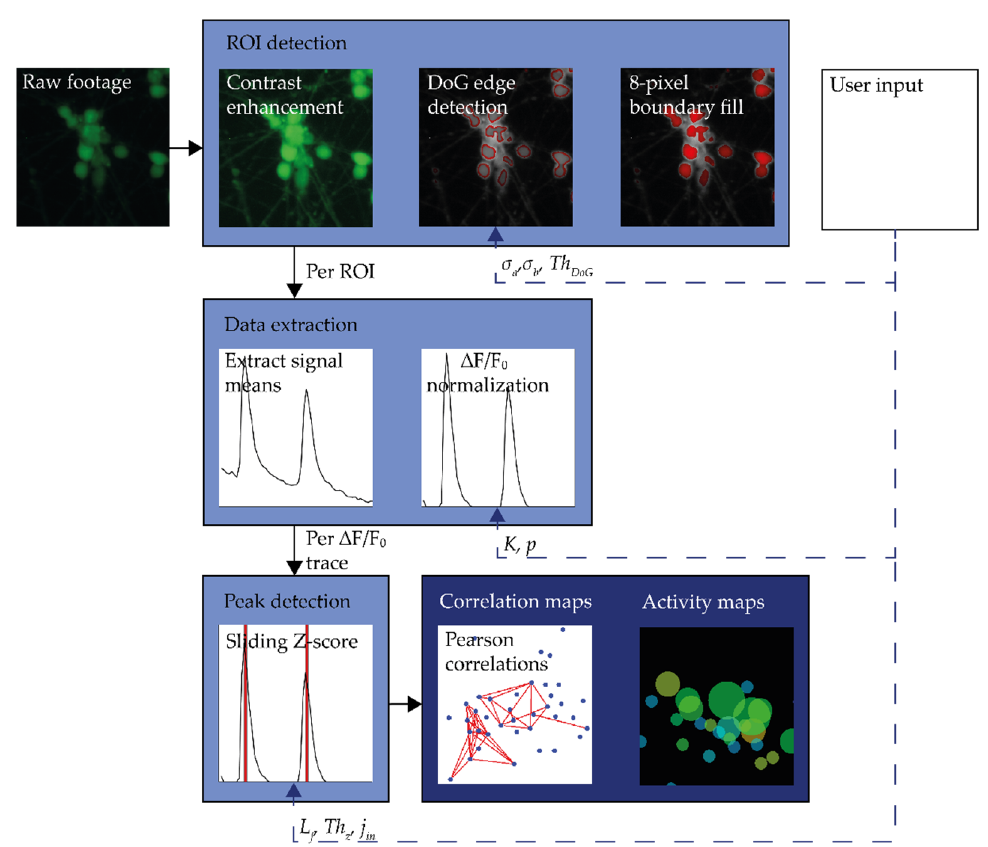
Figure 1. The workflow of CALIMA 2.0 with the processing steps indicated by light blue blocks and the outputs by dark blue blocks. Furthermore, the user-set input parameters are indicated for each processing step.